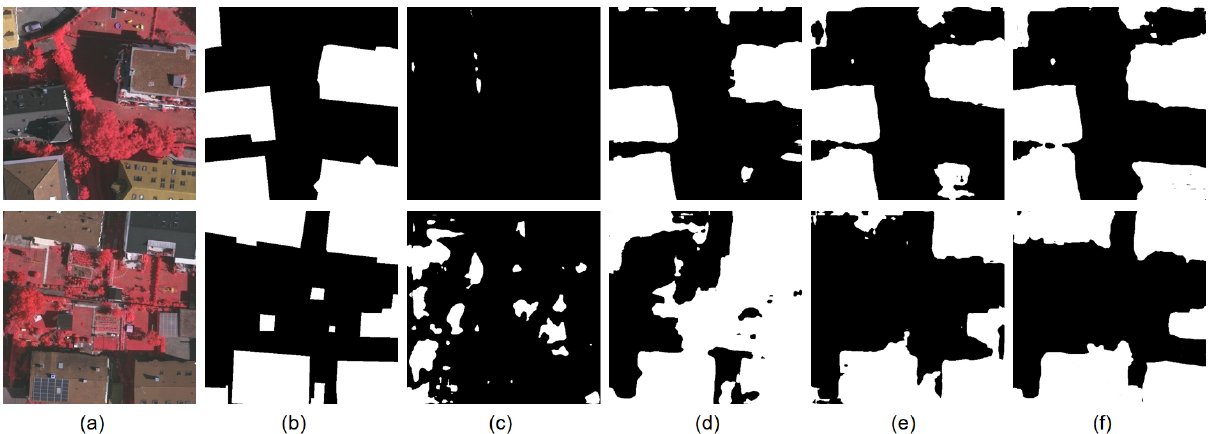
Figure 11. Segmentation results in Potsdam → Vaihingen experiment. White and black pixels represent buildings and background. ( a ) Vaihingen. ( b ) Label. ( c ) DeeplabV3+. ( d ) Color matching. ( e ) CycleGAN. ( f )